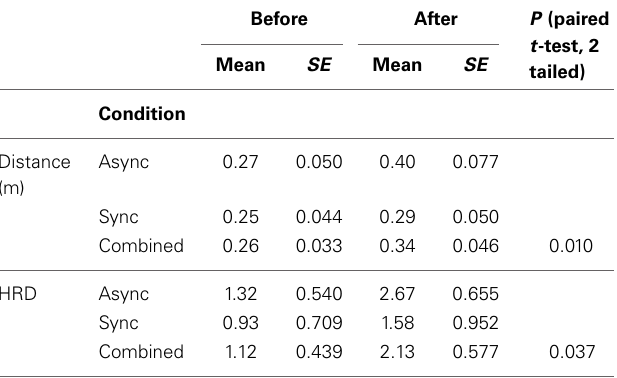
Table 2 | HRD and Distance